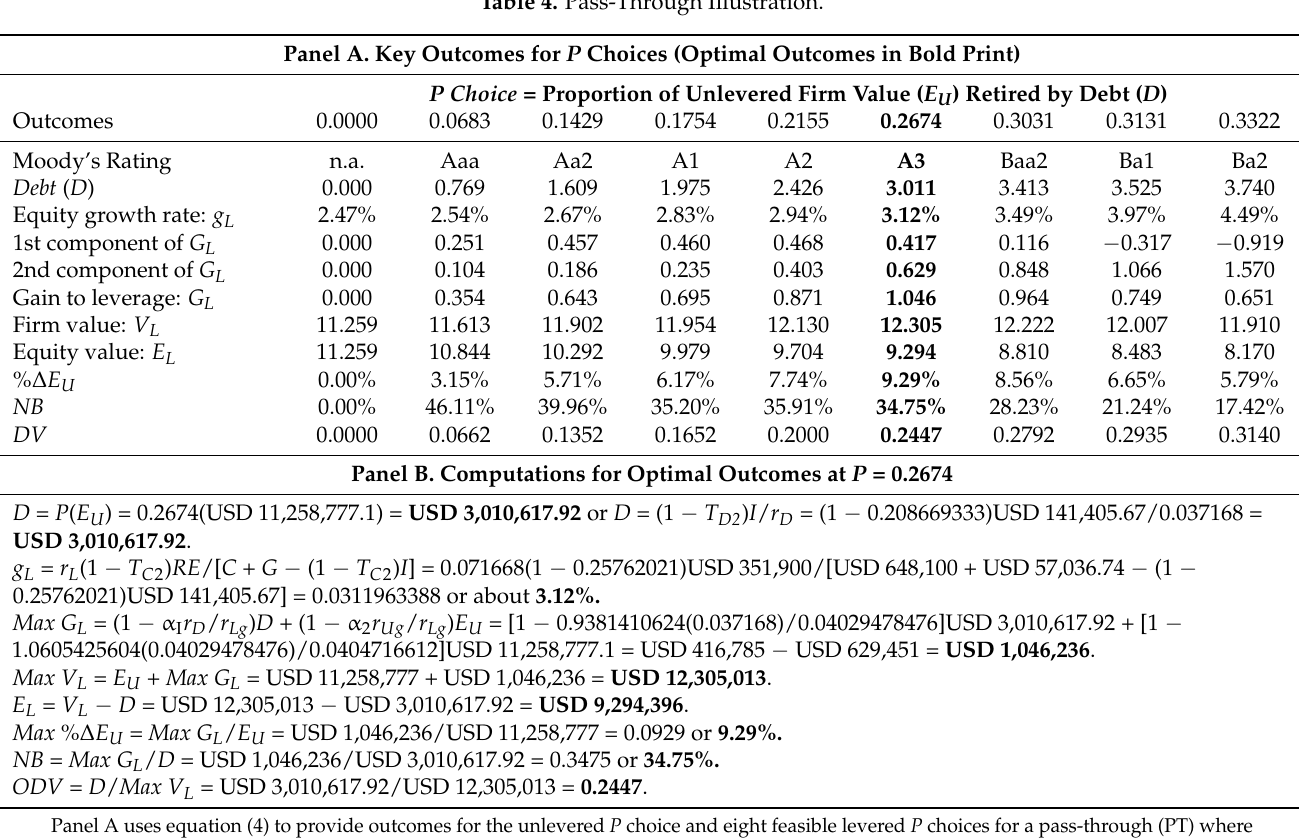
Table 4. Pass-Through Illustration. Panel A. Key Outcomes for P Choices (Optimal Outcomes in Bold Print)